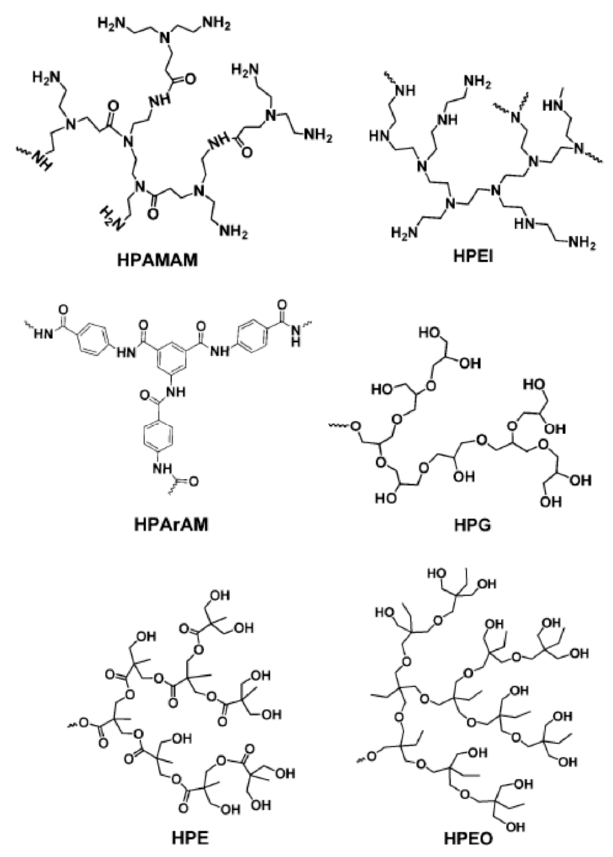
Figure 6. Schematic structures of classic HMs (and their acronyms) used as stabilizers to prepare